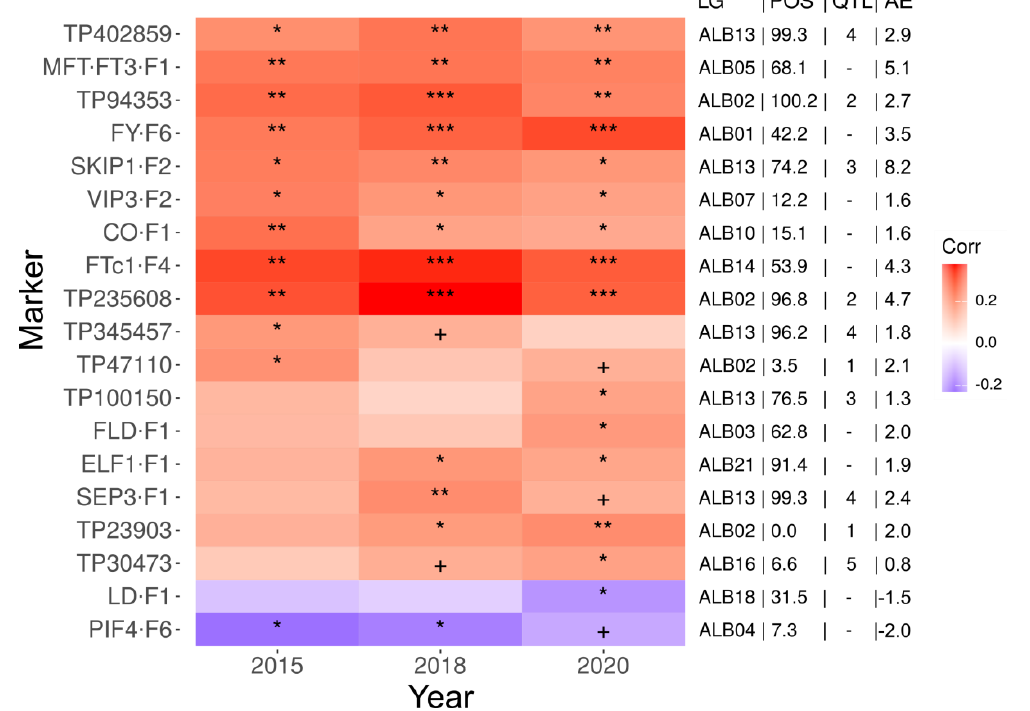
Figure 2. Correlation between the phenotype (the number of days from sowing to flowering) and the genotype (marker segregation) in white lupin germplasm collection. Color scale visualizes Spearman’s rank correlation coefficient values (Corr). Abbreviations are as follows: LG, linkage group; POS; position in the linkage group in centimorgans; QTL, the number of assigned QTL; AE, additive effect (See Supplementary Table S4). ***- p value <0.001; **- p value < 0.01; *- p value < 0.05; + p value < 0.1.